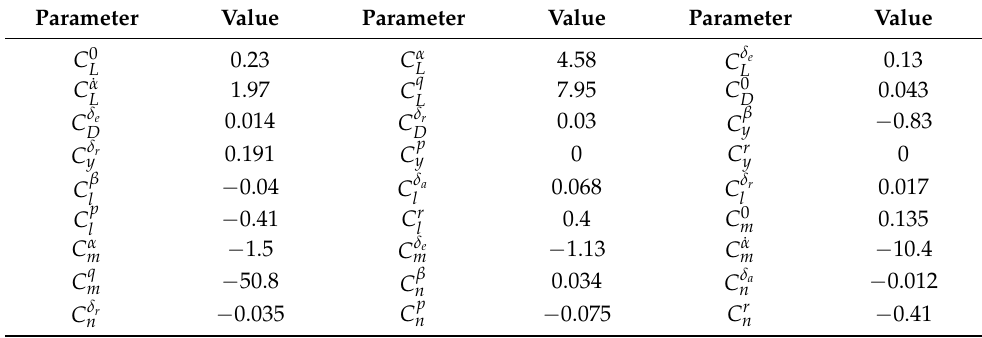
Table 2. Parameters of aerodynamic coefficients for US 25e.